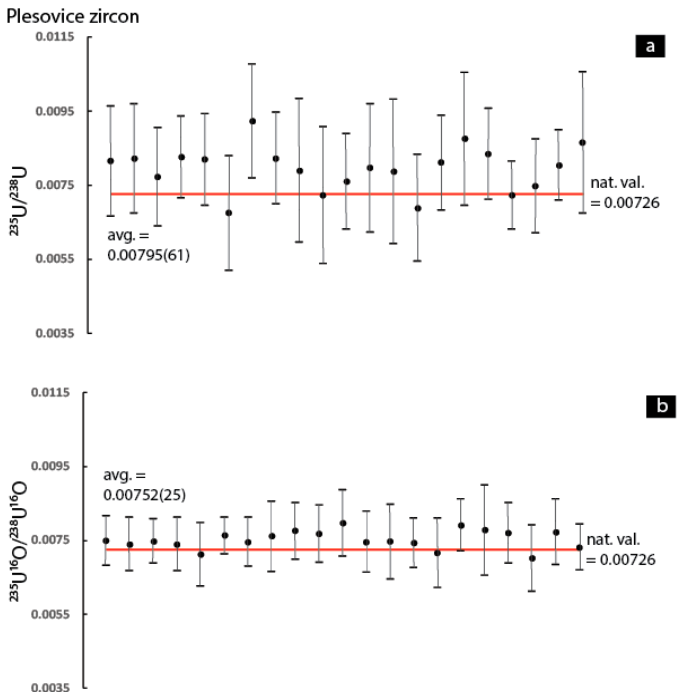
Figure 10. Plot of each analysis’s ( a ) 235 U / 238 U and ( b ) 235 U 16 O / 238 U 16 O ratio and its associated 1 σ uncertainty, for Plesovice zircon reference material analyzed using the 200 pA primary beam current and shown relative to the natural 235 U / 238 U of 0.00726 (red line) reported in [23]. Uncertainty of the value in [23] is considerably lower than the NanoSIMS results and is therefore not shown here.